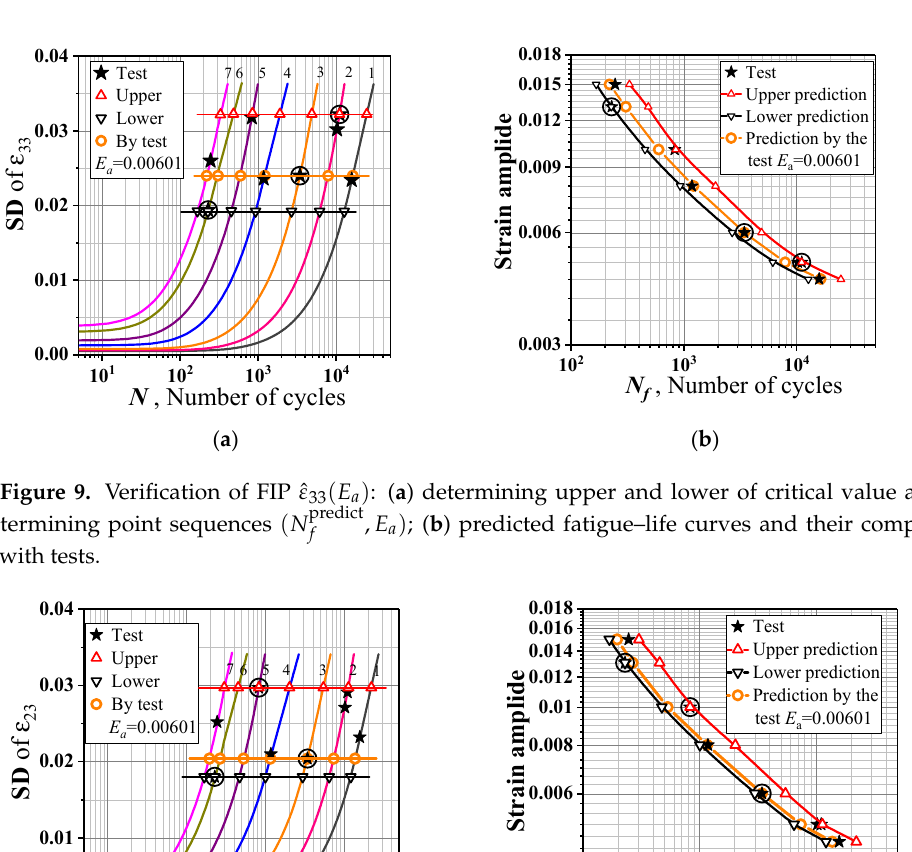
ˆ ( ) E ε : ( a ) determining upper and lower of critical value and deter- 23 a